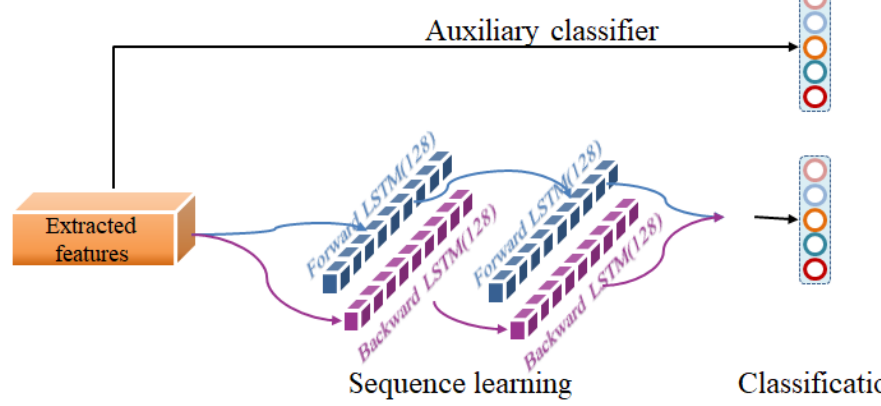
Figure 9. Sequence learning and classification.